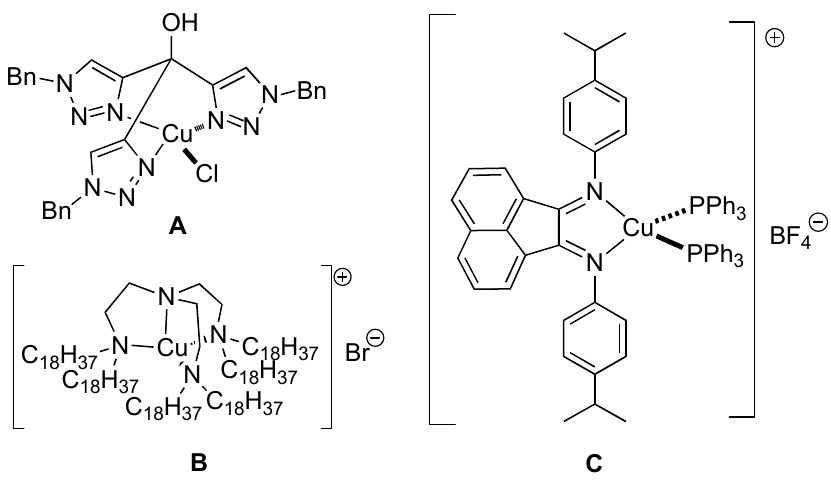
Figure 1. Reported preformed copper(I) catalysts with N -ligands.